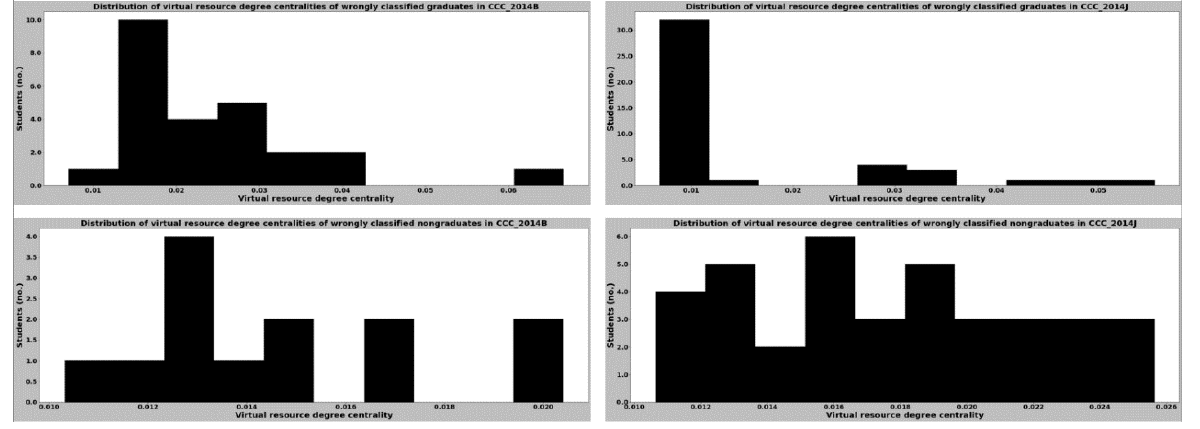
Distribution of Virtual Resource Degree Centralities for Wrongly Classified Learners in Course CCC in